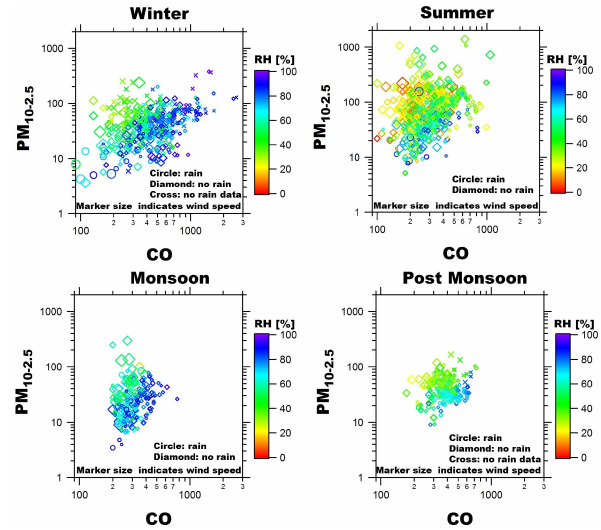
Figure 7. Dependence of coarse-mode PM mass loadings on emis- sion of gas-phase precursors and meteorological parameters for the different seasons. The marker shape distinguishes PM mass load- ings measured during rain events (circles) and under dry condi- tions (diamonds); data points obtained while the rain gauge was not working are marked with crosses. Marker size is proportional to wind speed. The smallest markers indicate WS ≤ 1ms − 1 , the largest markers WS ≥ 15ms − 1 . Markers are colour coded with rel- ative